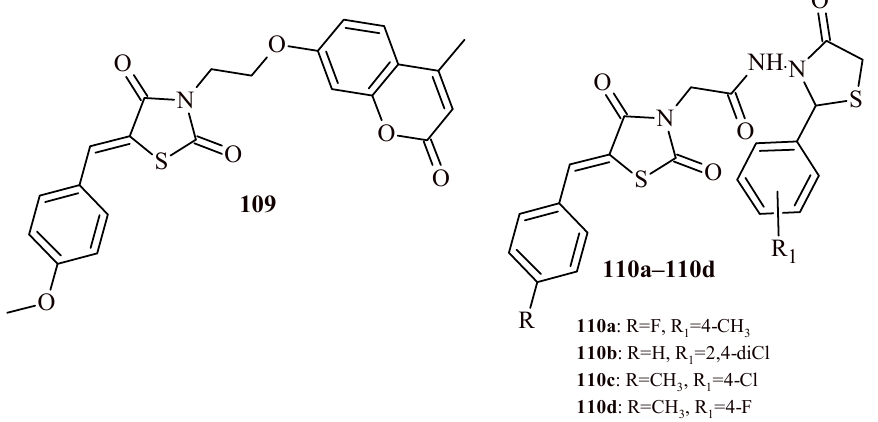
Figure 46. Influence of substituents on antimicrobial activity compounds ( 5a – 5s ). It is worth to pay attention to Compound 109 (Figure 47) among the TZD derivatives, that exhibited good antibacterial as well as antifungal activity. The minimal inhibitory concentration against S. aureus and B. subtilis was 0.5 µg/mL. This derivative was active against Gram-negative strain E. coli and P. aeruginosa at MIC = 1 µg/mL. The Compound 109 showed antifungal activity also at Concentration 1 µg/mL against Aspergillus flavus , Trichoderma harzianum , Penicillium chrysogenum and C. albicans . Al these values were better than for reference drugs ciprofloxacin (MIC = 2 µg/mL) and fluconazole (MIC = 2 µg/mL) [115].